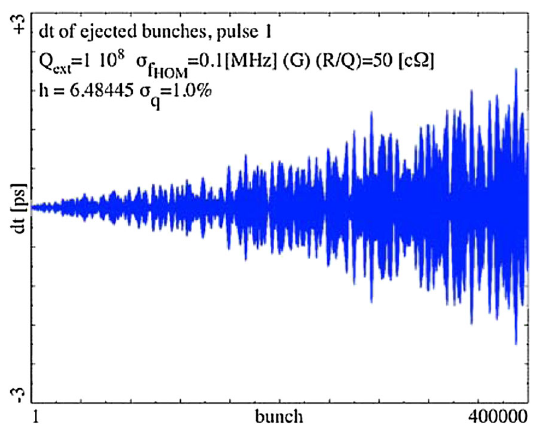
FIG. 61. (Color) dt at ejection [ (cid:3) 3 ps ] corresponding to dE of Fig. 59 (pulse 1).